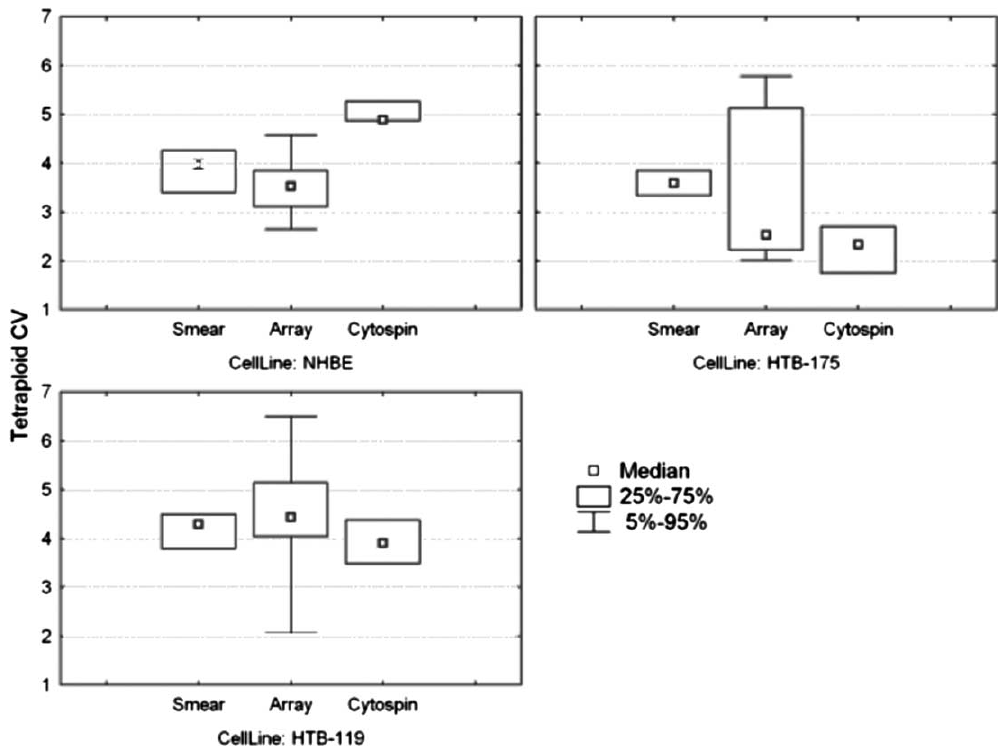
Fig. 7. Three different cell lines showing tetraploid Coefficient Variation (CV) for three different preparation methods (smear, array and